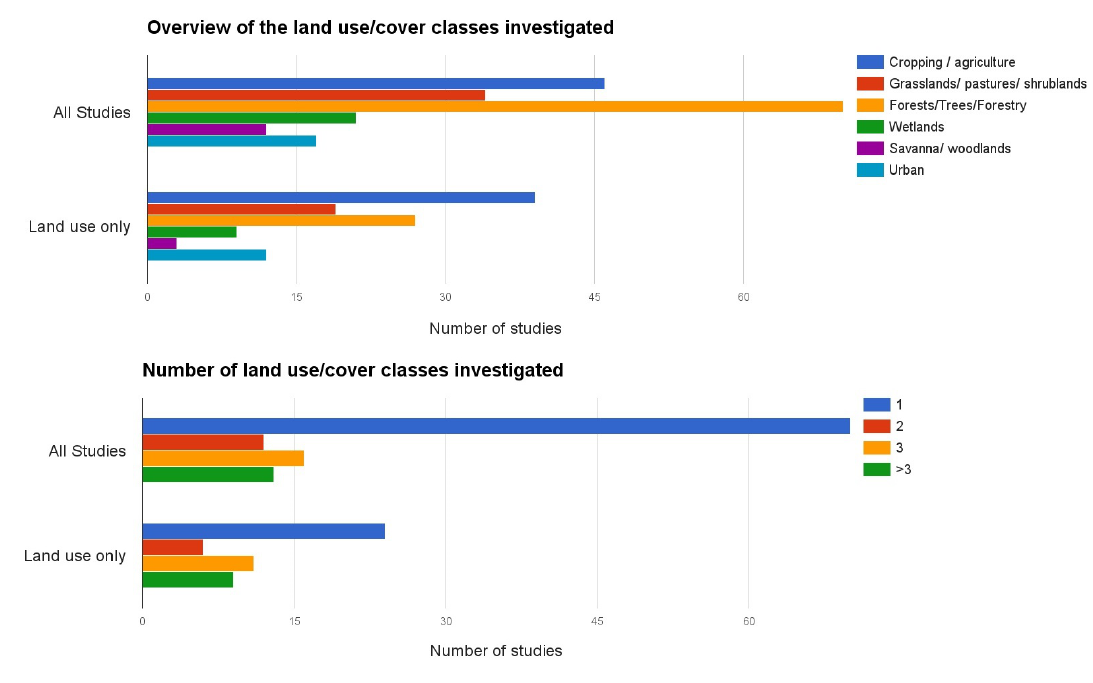
Figure 2. Summary of land use/cover classes included in the